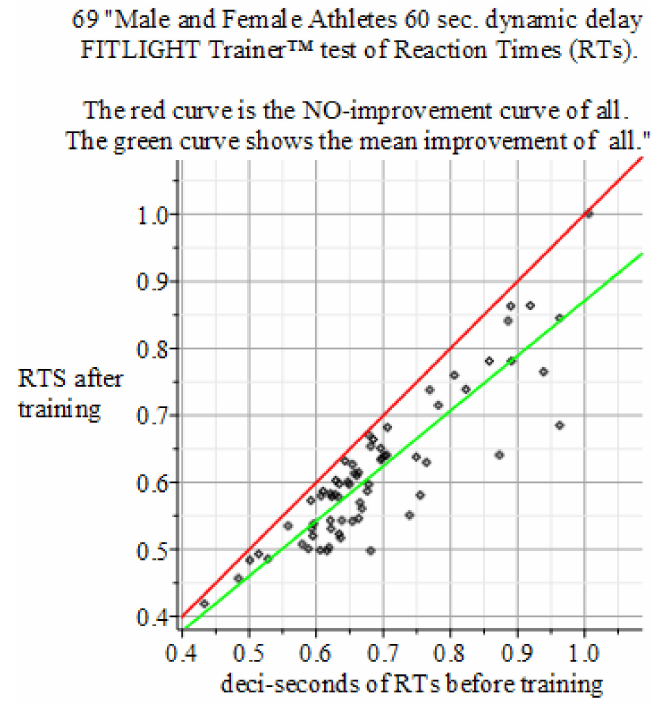
Figure 6. Summary of the above results. Reaction Times: 60 s dynamic delay FITLIGHT Trainer™ equipment. Sample size of 69 men and women. Baseline sample mean 0.687 s, σ = ± 0.1194, and Final mean 0.614 s with σ = ± 0.1099. P -value 0.0000914155. Result: Hypothesis of NO-Effect of training is: Rejected. The mean outcome of the 225 Reaction Time experiments is: Reaction Time performance improvement of +10.8% against the initial intake